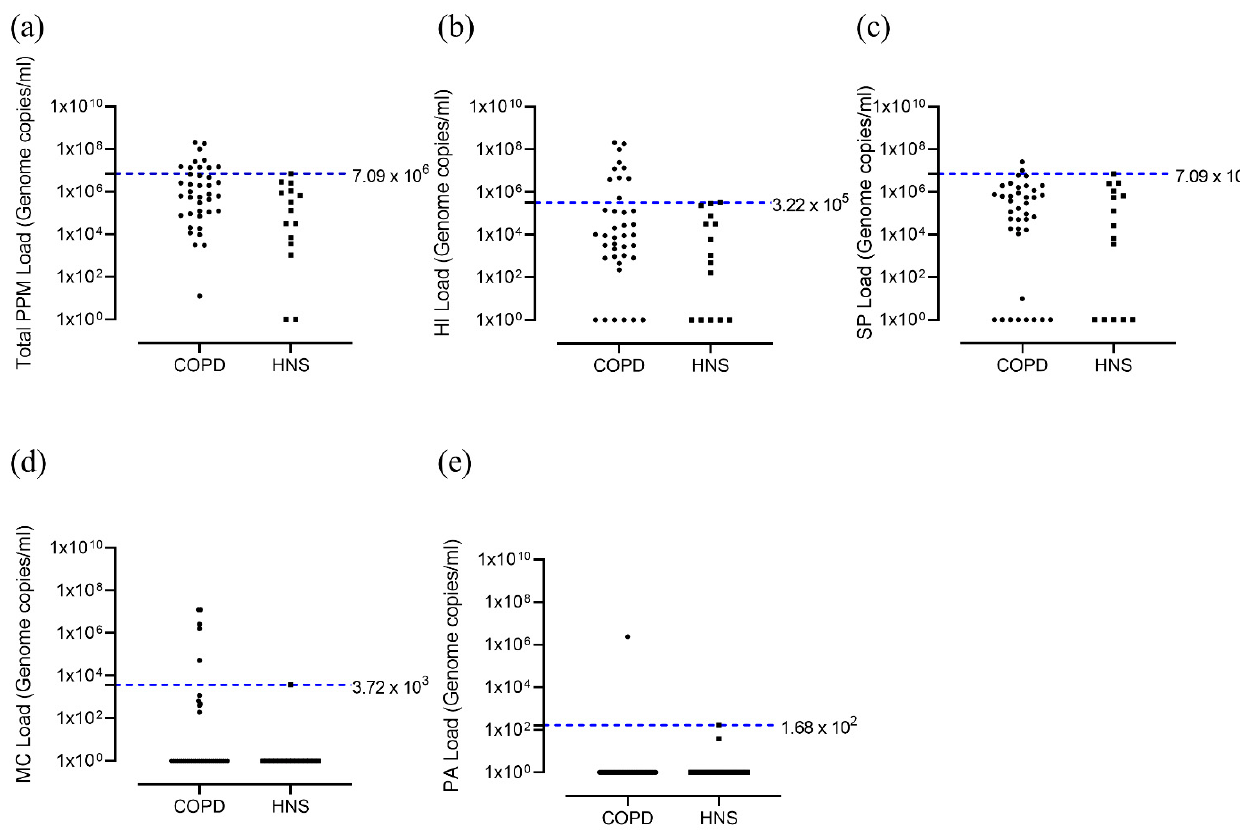
Figure 2. Total bacterial load and load for different PPMs; COPD vs. HNS controls at 6 months. Sputum from COPD patients ( n = 39) at 6 months visit and healthy non-smokers ( n = 15) were analysed for qPCR for presence of H. influenzae , S. pneumoniae , M. catarrhalis and P. aeruginosa. Data represent bacterial genome copies for individual patients for ( a ) total bacterial load and that for different bacterial species; ( b ) H. influenzae , ( c ) S. pneumoniae , ( d ) M. catarrhalis and ( e ) P. aeruginosa . COPD, Chronic obstructive pulmonary disease; HNS, healthy non-smoker; HI, Haemophilus influenzae ; MC, Moraxella catarrhalis ; PPM, potentially pathogenic microorganism; PA, Pseudomonas aeruginosa ; SP, Streptococcus pneumoniae .